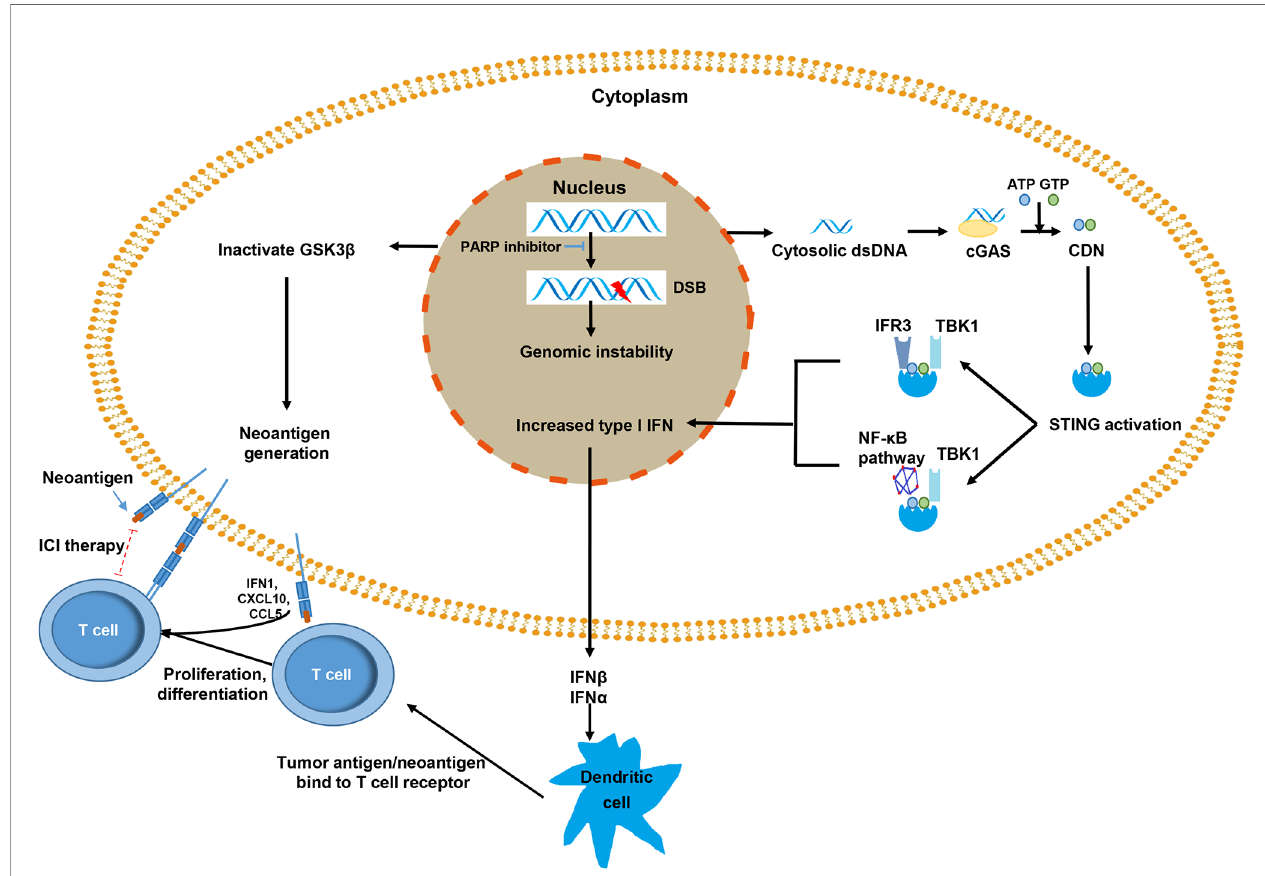
FIGURE 1 | The mechanisms by which poly(ADP ribose) polymerase (PARP) inhibitors promote immune response against tumor cells. The PARP inhibitor inactivates GSK3 b , which can lead to increased PD-L1 expression in tumor cells. The release of dsDNA and the activation of the cGAS – STING pathway results in the increased expression of type I IFN via the TBK1-IRF3 and TBK1-NF- k B pathways. Type I IFN activates immune effector cells by promoting the presentation of tumor dendritic cell antigen/neoantigen, and the major histocompatibility complex of a dendritic cell binds to T cell receptors and activates T cells. The activated T cells in fi ltrate the tumors and recognize tumor antigens that presented on the tumor cell surface. PD-L1 expression, as an immune escape signal, can be targeted with immune checkpoint inhibitor therapy (red dotted